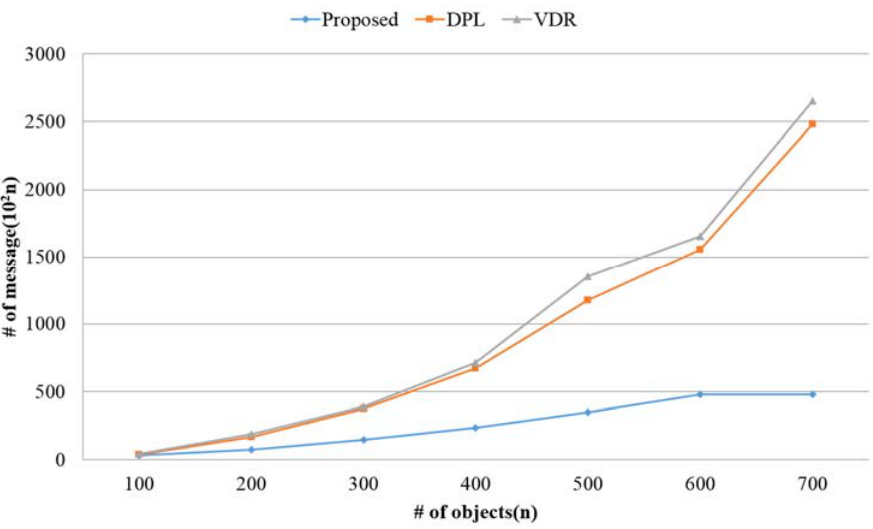
Figure 9. Number of messages generated according to the number of objects.